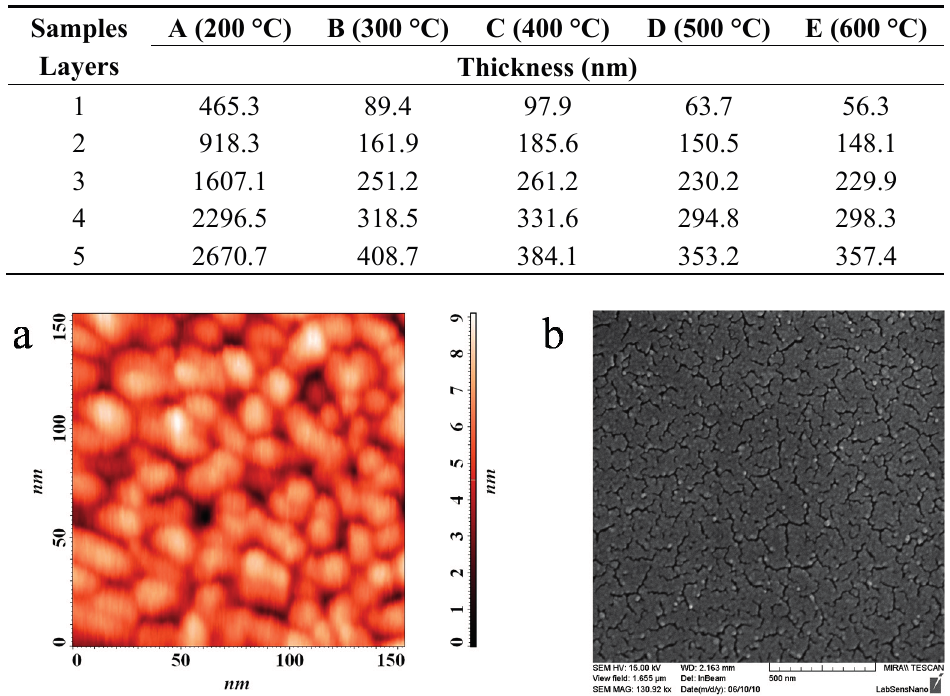
Table 1. Thickness of prepared samples as determined by ellipsometry.